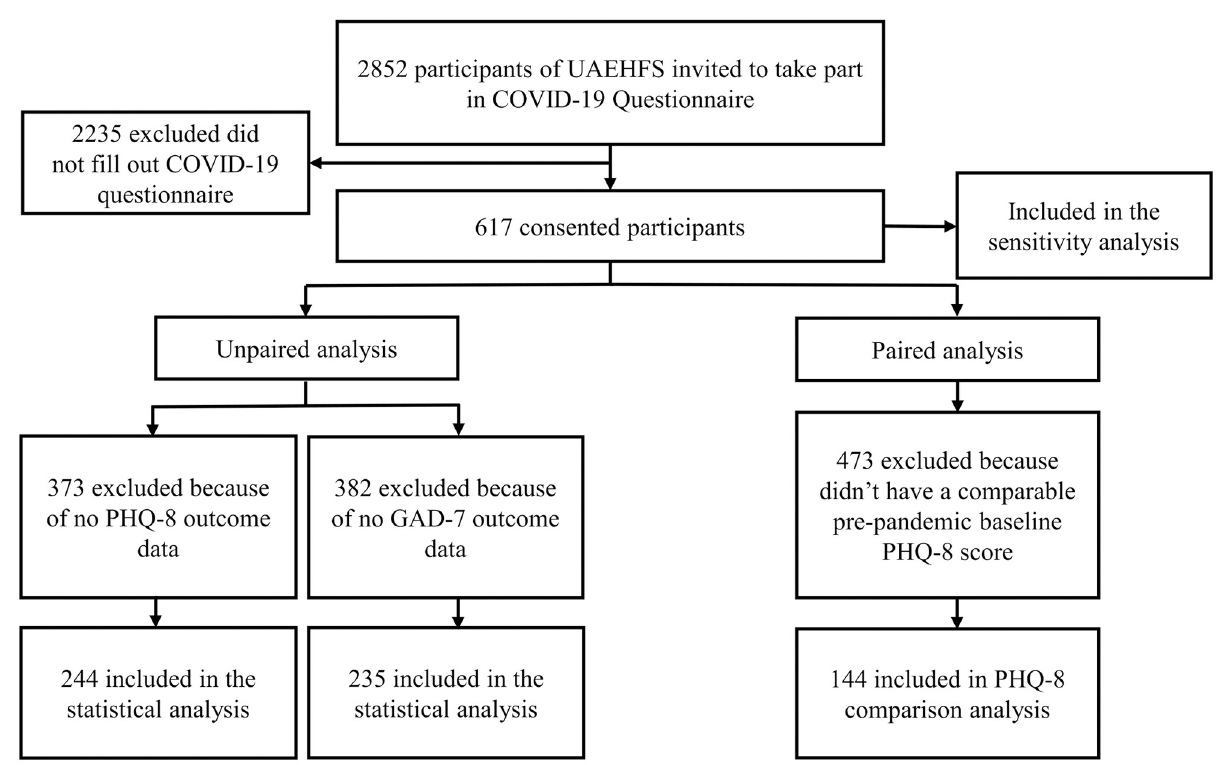
Fig 1. Flow chart showing selection into the